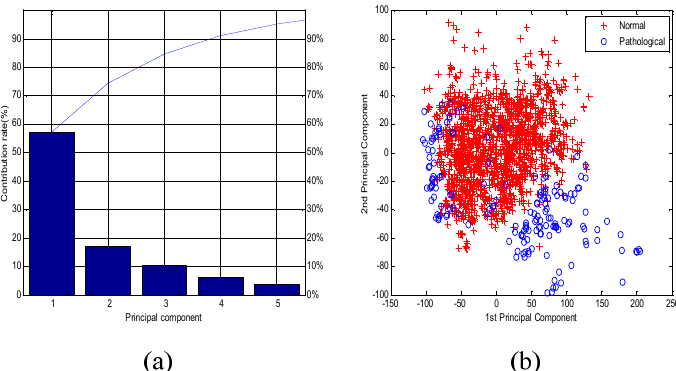
Figure 7. ( a ) Principal components (PCs) based on the contribution rate using principal component analysis (PCA); ( b ) The distribution between the first PC and second PC for two groups (normal and pathological).